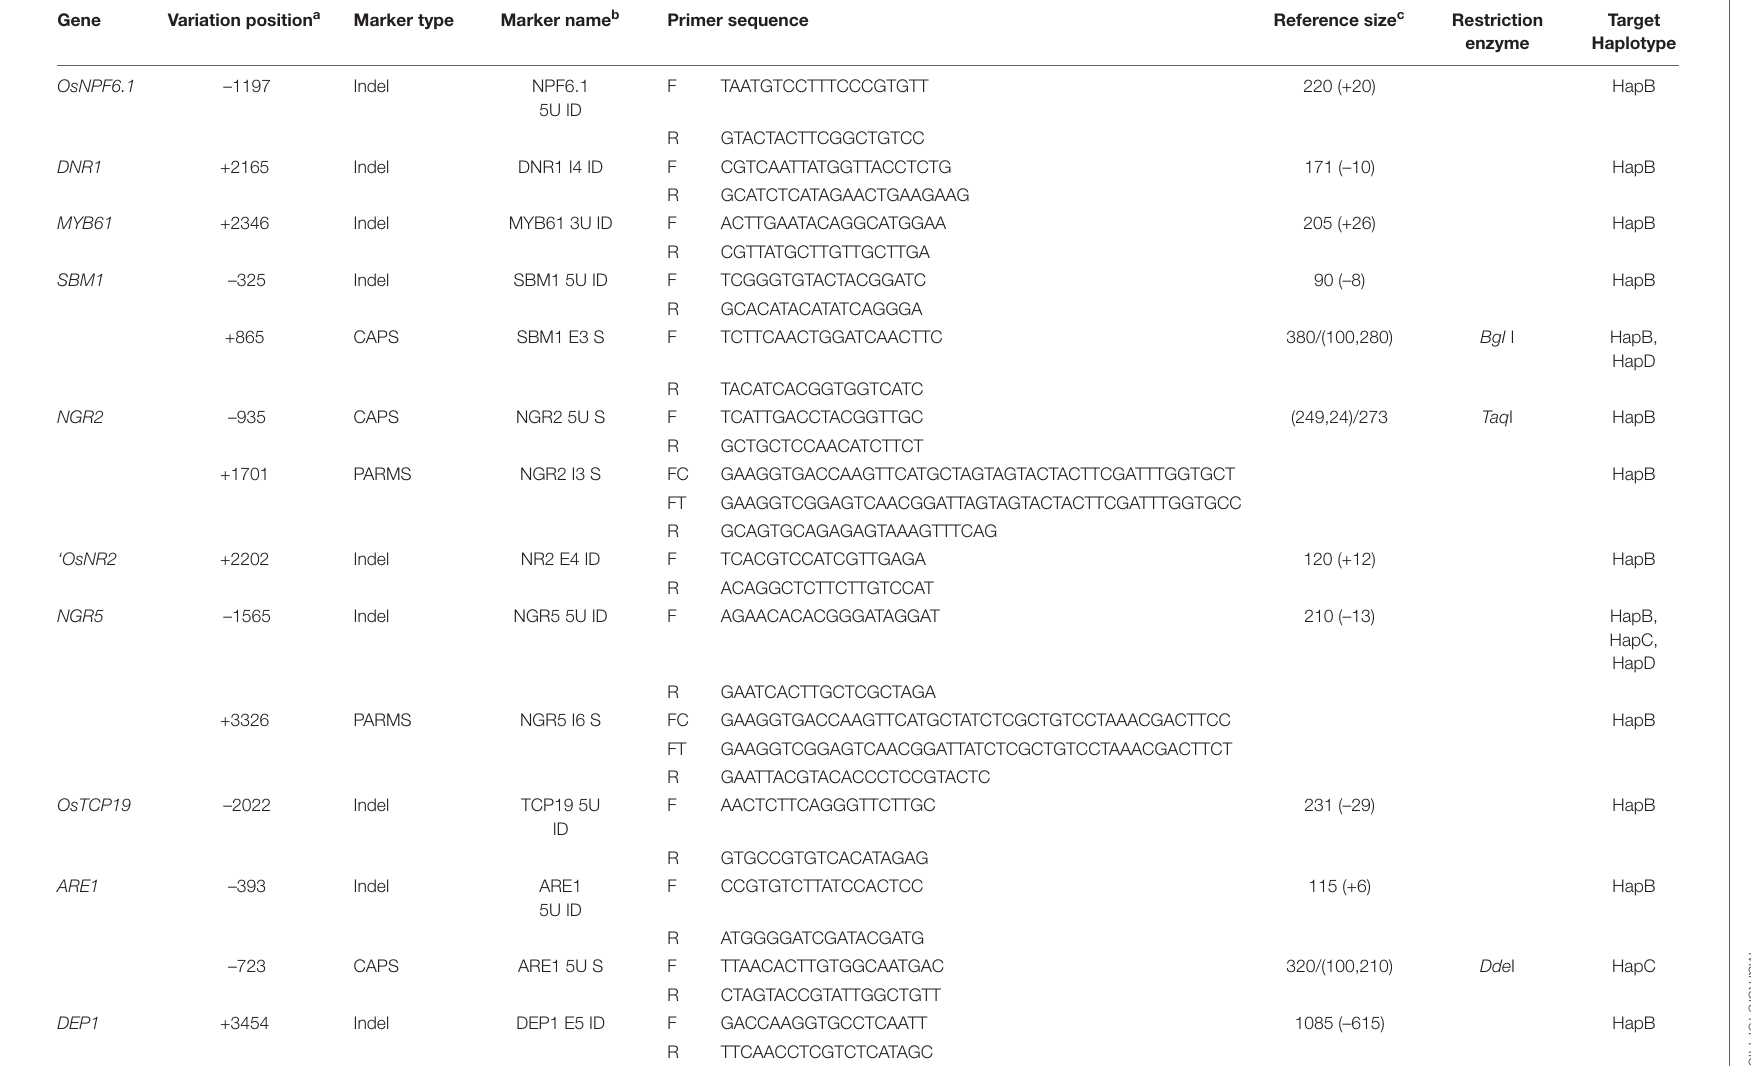
TABLE 3 | Intragenic markers for the 14 NUE genes. Gene Variation position a Marker type Marker name b Primer sequence Reference size c Restriction